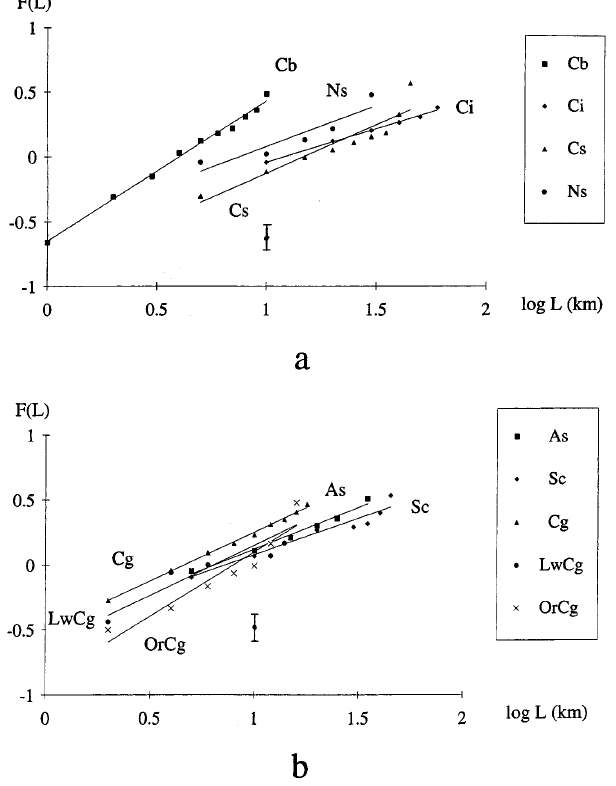
Fig. 5a, b. Cumulative frequency distributions of size ( L , in km) and Weibull fitting: a for types Cb, Ci, Cs, Ns; b for types As, Sc, Cg, LwCg, OrCg. The error bar displayed is calculated using Eqs. (16) and (3). Its magnitude is roughly constant in the range of